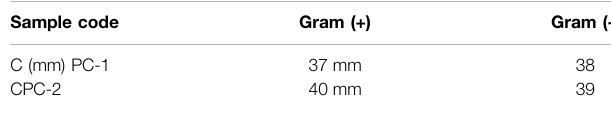
TABLE 1 | Thermogravimetric data of the nano fi bers. Sample code